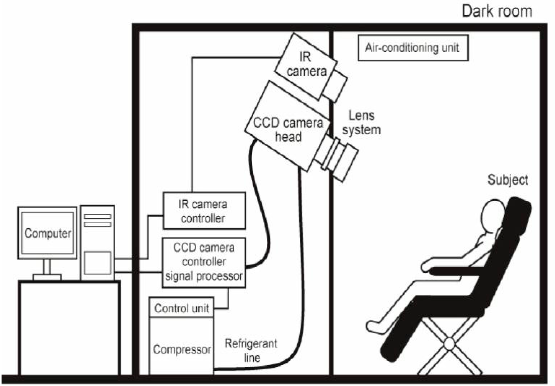
Figure 5. Schematic illustration of experiment setup.